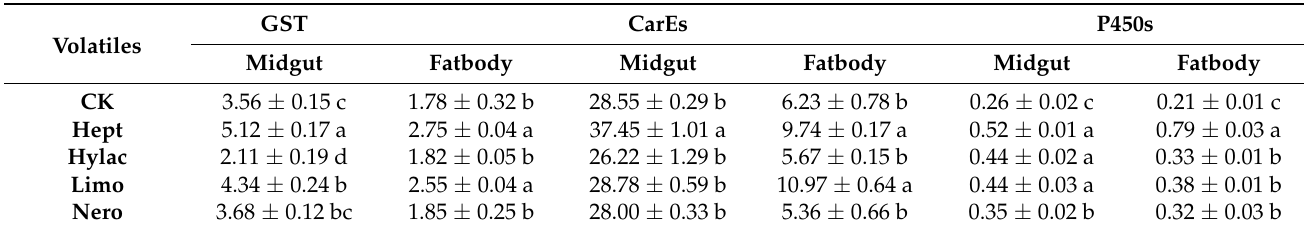
Table 1. Activities of glutathione-s-transferase (GST), carboxylesterase (CarE) and cytochrome P450 enzymes (P450s) in midguts and fatbodies of Helicoverpa armigera larvae exposed to volatile 2-heptanone (Hept), cis -3-hexenyl acetate